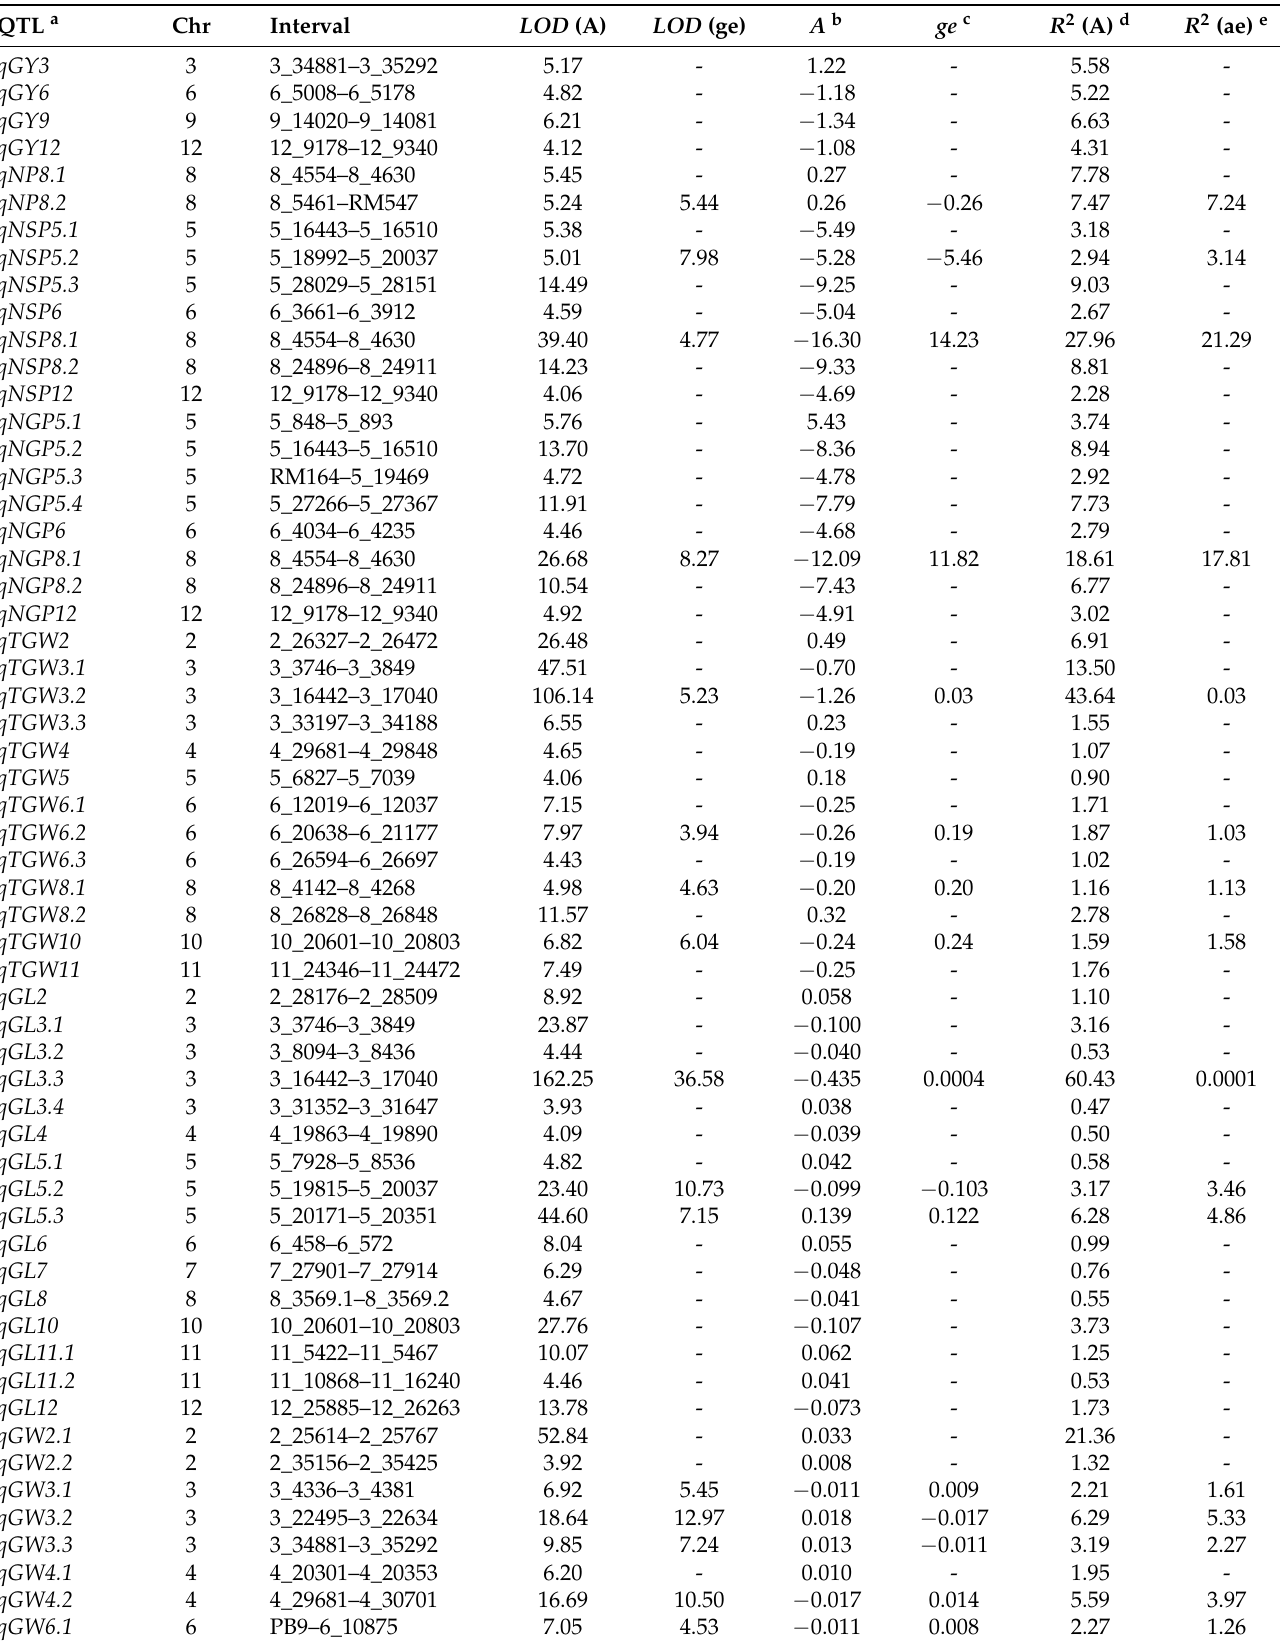
Table 5. QTL detected for the eight yield traits in the D71/ZH161 RIL